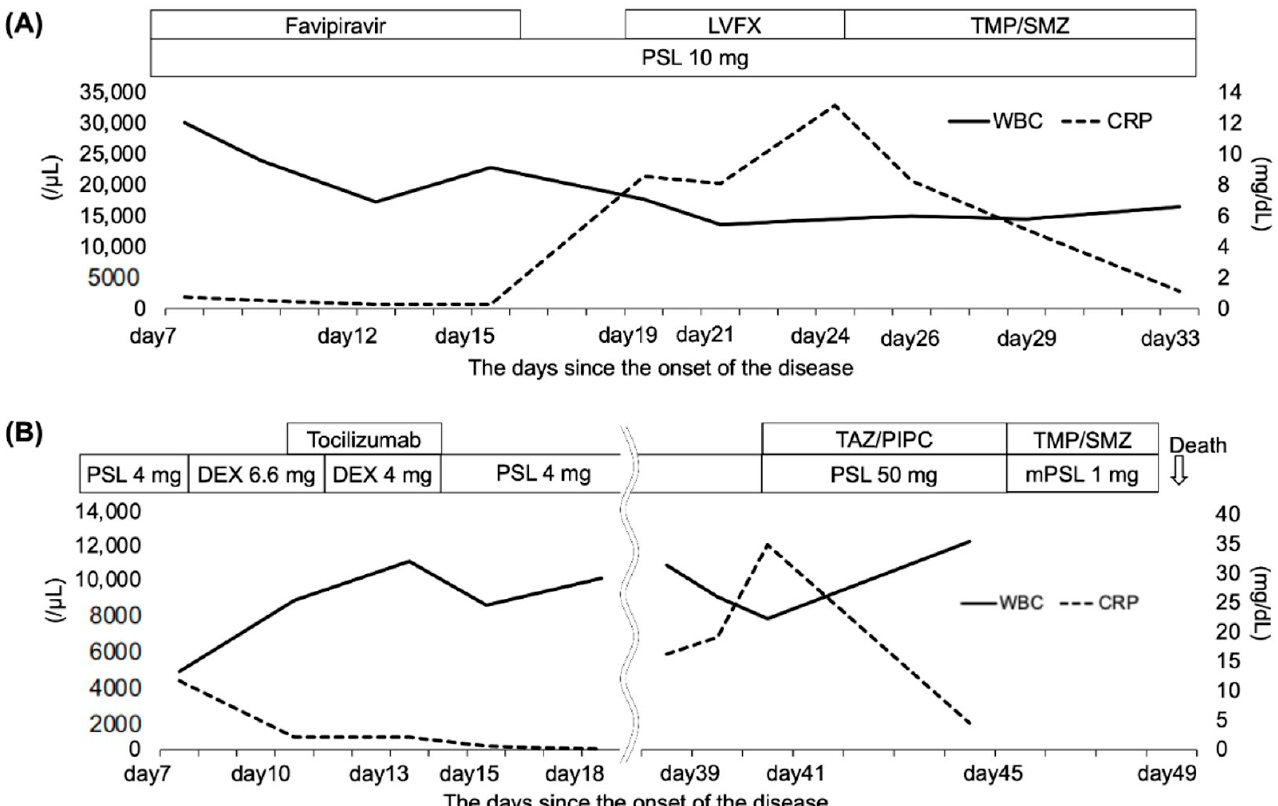
Figure 1. The clinical course of the patients. ( A ) case 1. ( B ) case 2. WBC: white blood cell, CPR: C- reactive protein, PSL: prednisolone, DEX: dexamethasone, LVFX: Levofloxacin, TMP/SMX: trimetho- prim/sulfamethoxazole, TAZ/PIPC: tazobactam/piperacillin.